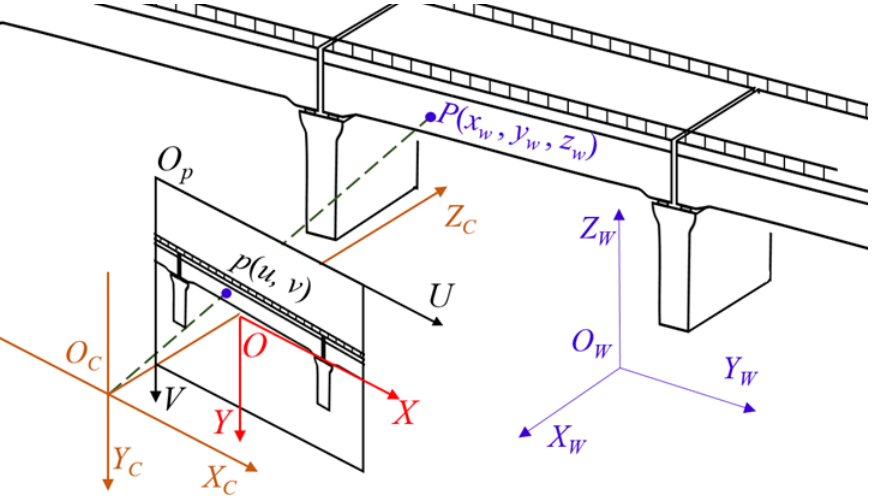
Figure 2. Pinhole camera model and the four coordinate systems.